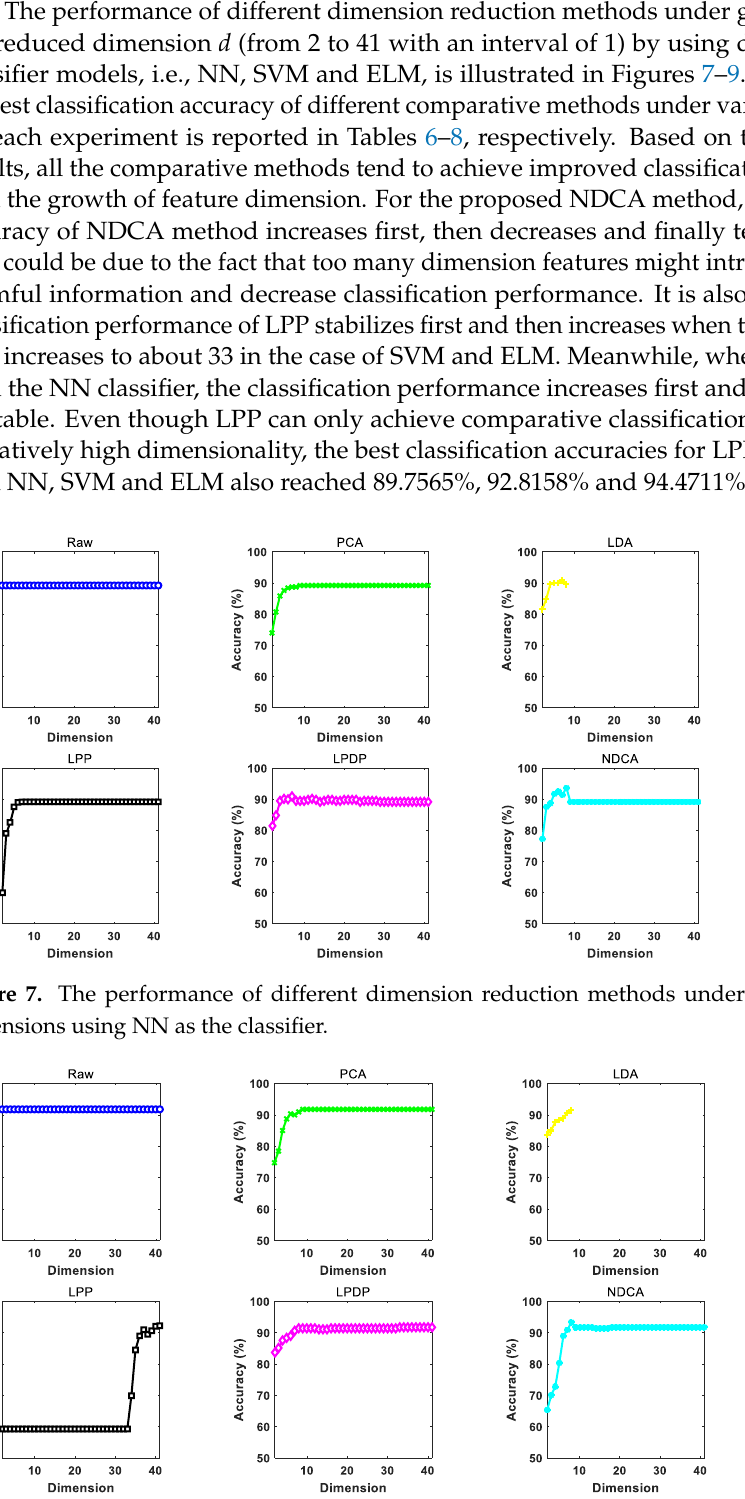
Figure 9. The performance of different dimension reduction methods under different reduced dimensions using ELM as the classifier. Generally speaking, the proposed NDAC method can yield the best classification accuracies of 94.1971%, 93.6377% and 95.1895% with different classifiers. Table 9 further summarizes the performance improvement of the proposed NDCA method in comparison with different comparative methods by using different classifiers.